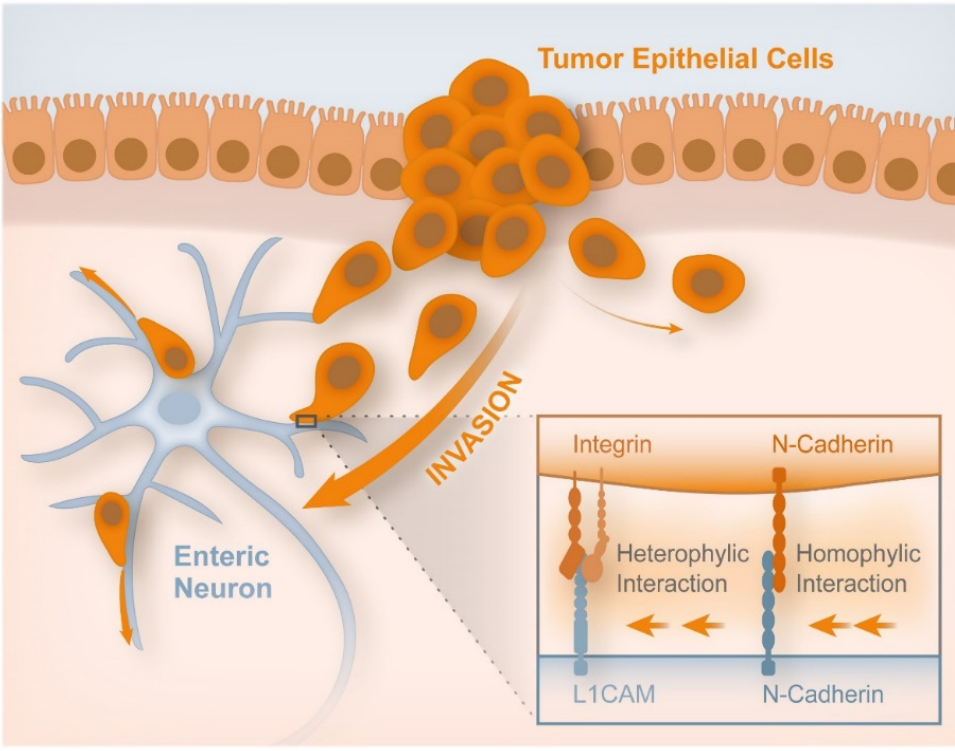
Figure 5. Cells involved in the adhesion and migration of CRC cells through the local enteric neurons network. It is speculated that tumor epithelial cells migration is performed along the neuronal fibers, through the heterophilic bond of L1CAM—integrin and suggesting the existence of homophilic bond of N-cadherin. These physical process guides the migration of CRC cells. Adapted from Duchalais et al. 111].